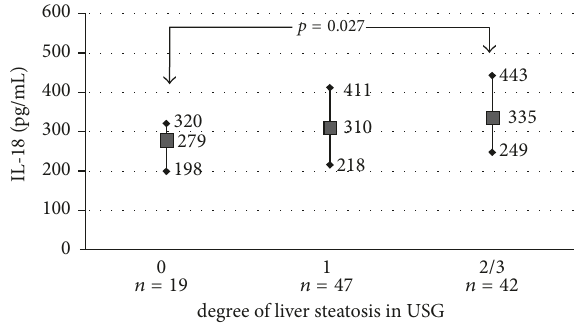
Figure 1: Median (min., max.) of IL-18 serum concentration depending on degree of liver steatosis in